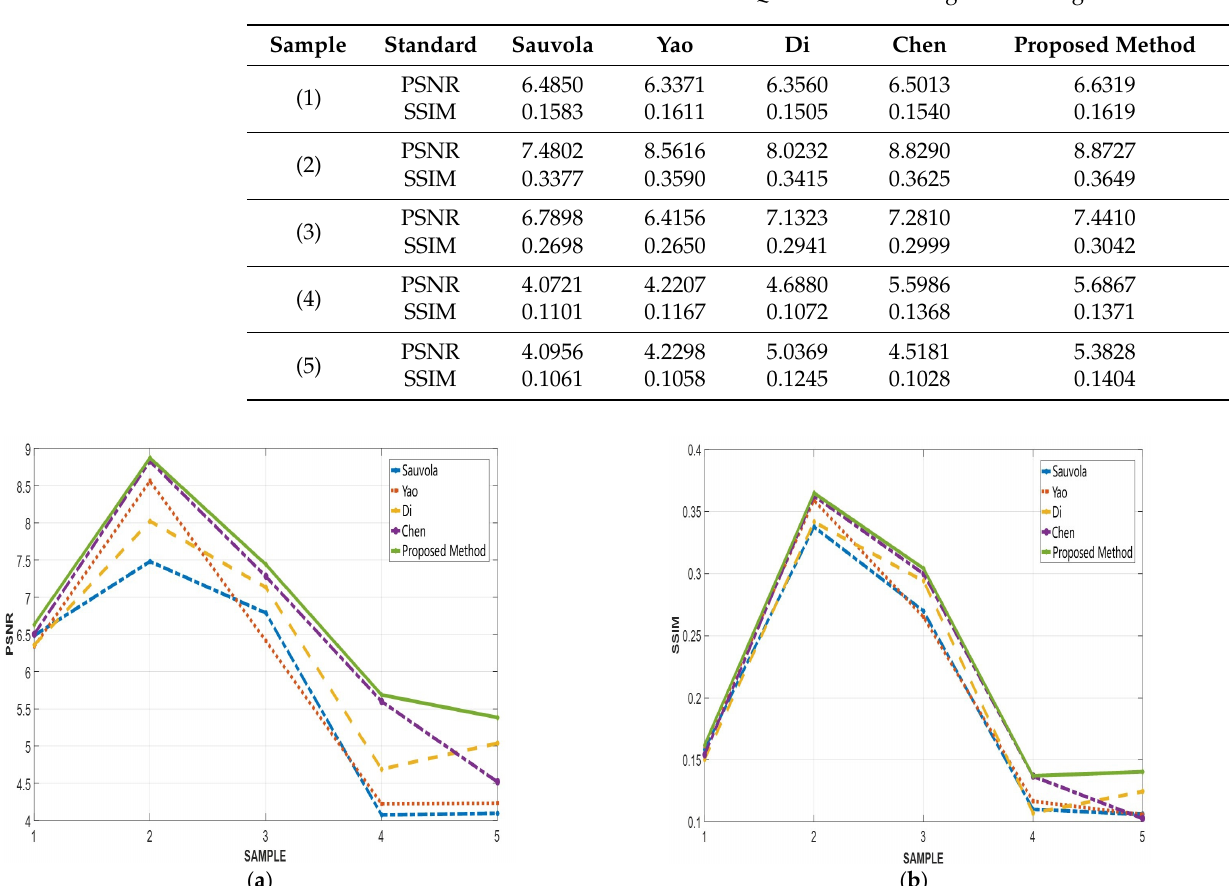
Figure 18. The original image and experimental results of different algorithms: ( a ) Original image;